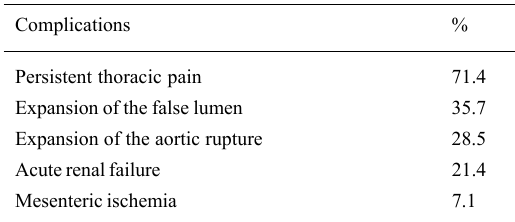
Table 2. Pre-operative